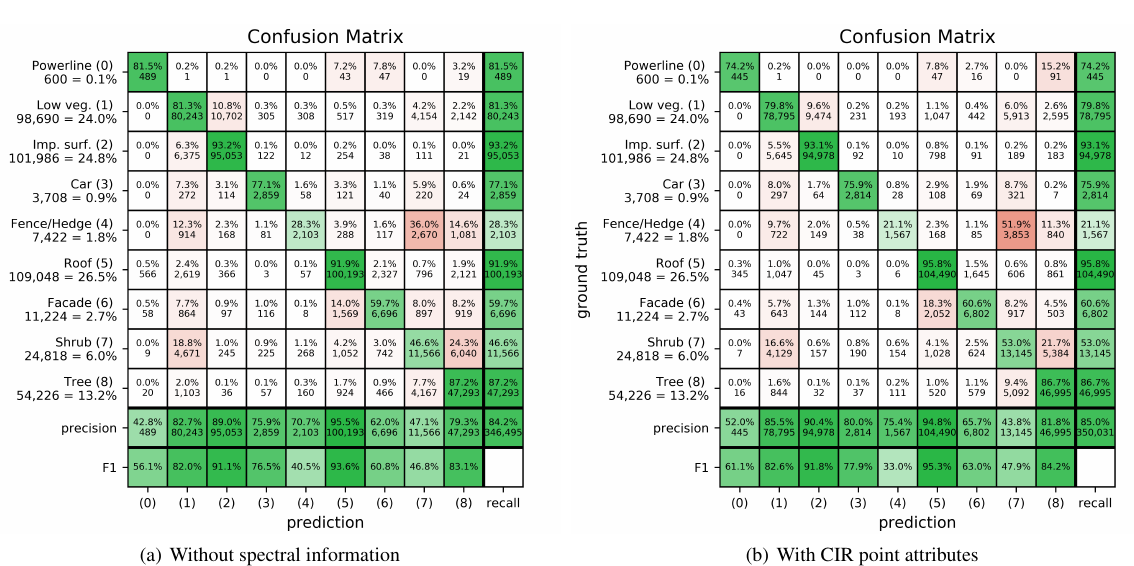
Table 1. Results on the V3D test set, evaluated on the original point cloud. Shown are mean and standard deviation regarding the overall accuracies from ten networks each, followed by the overall accuracy of their ensemble. Under the voxel sizes, the respective number of resulting voxels is reported. The same sample size was used for training and testing.